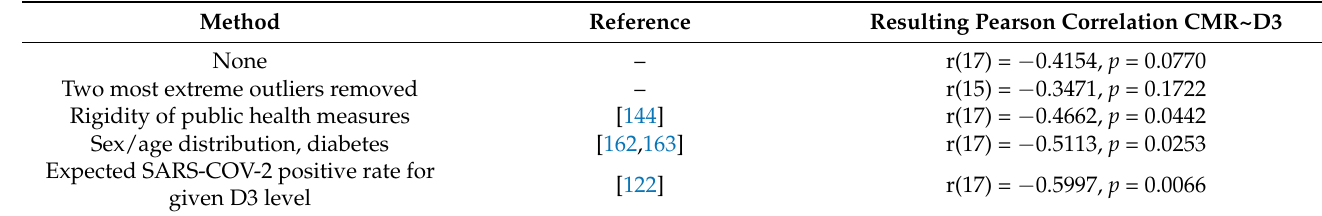
Table 3. Attempted corrections of the CMR values in the population study by Ahmad.